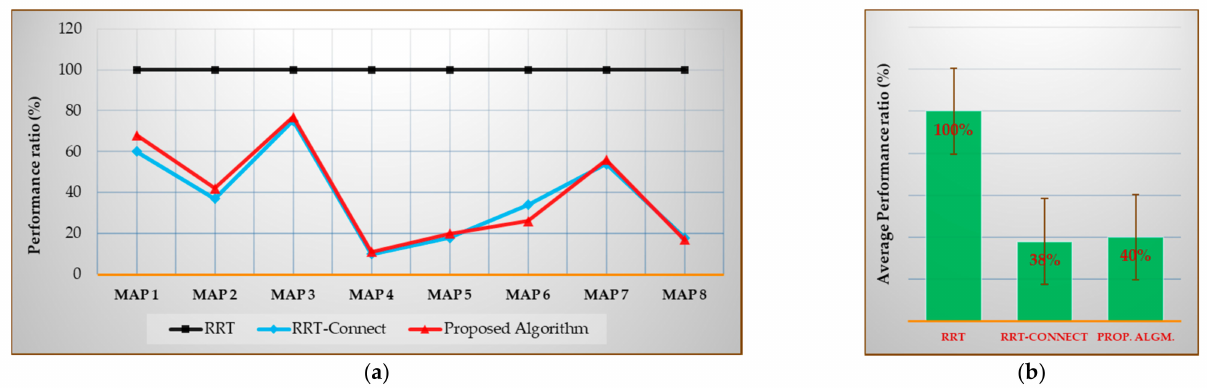
Figure 19. Experimental results in total for the average number of samples (for first path finding): ( a ) result of each map compared with the RRT algorithm ( x cmp ( i ) ); ( b ) average result compared with the RRT algorithm ( X cmp ).